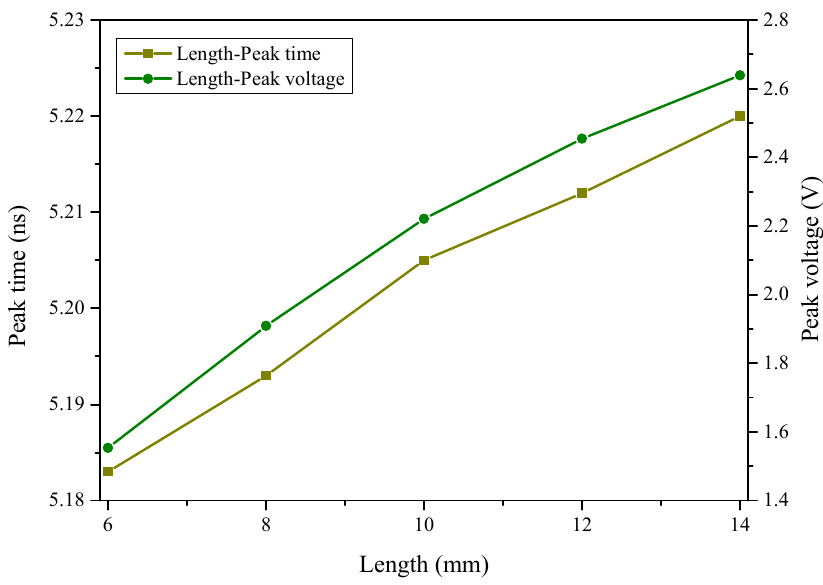
Figure 15. Relationship between peak time and peak voltage with the wire lengths.